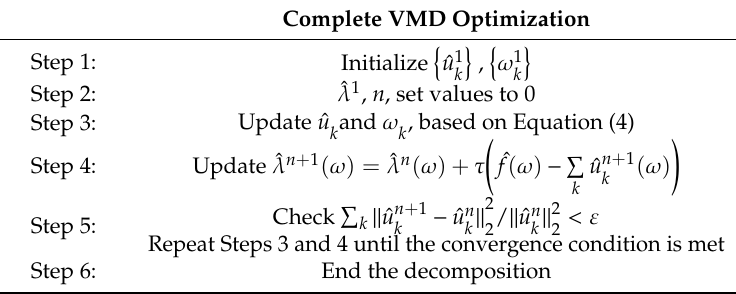
Table 1. The variational mode decomposition (VMD) algorithm